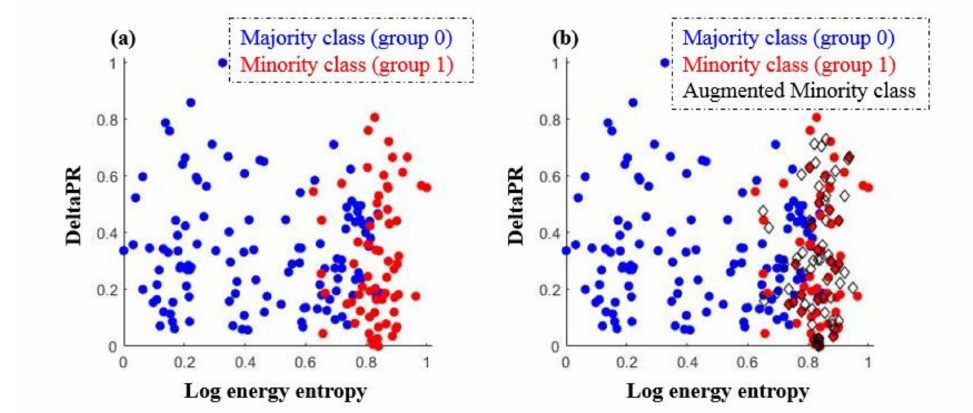
Figure 4. An oversampling example by SMOTE application: ( a ) Before applying SMOTE, ( b ) After applying SMOTE.